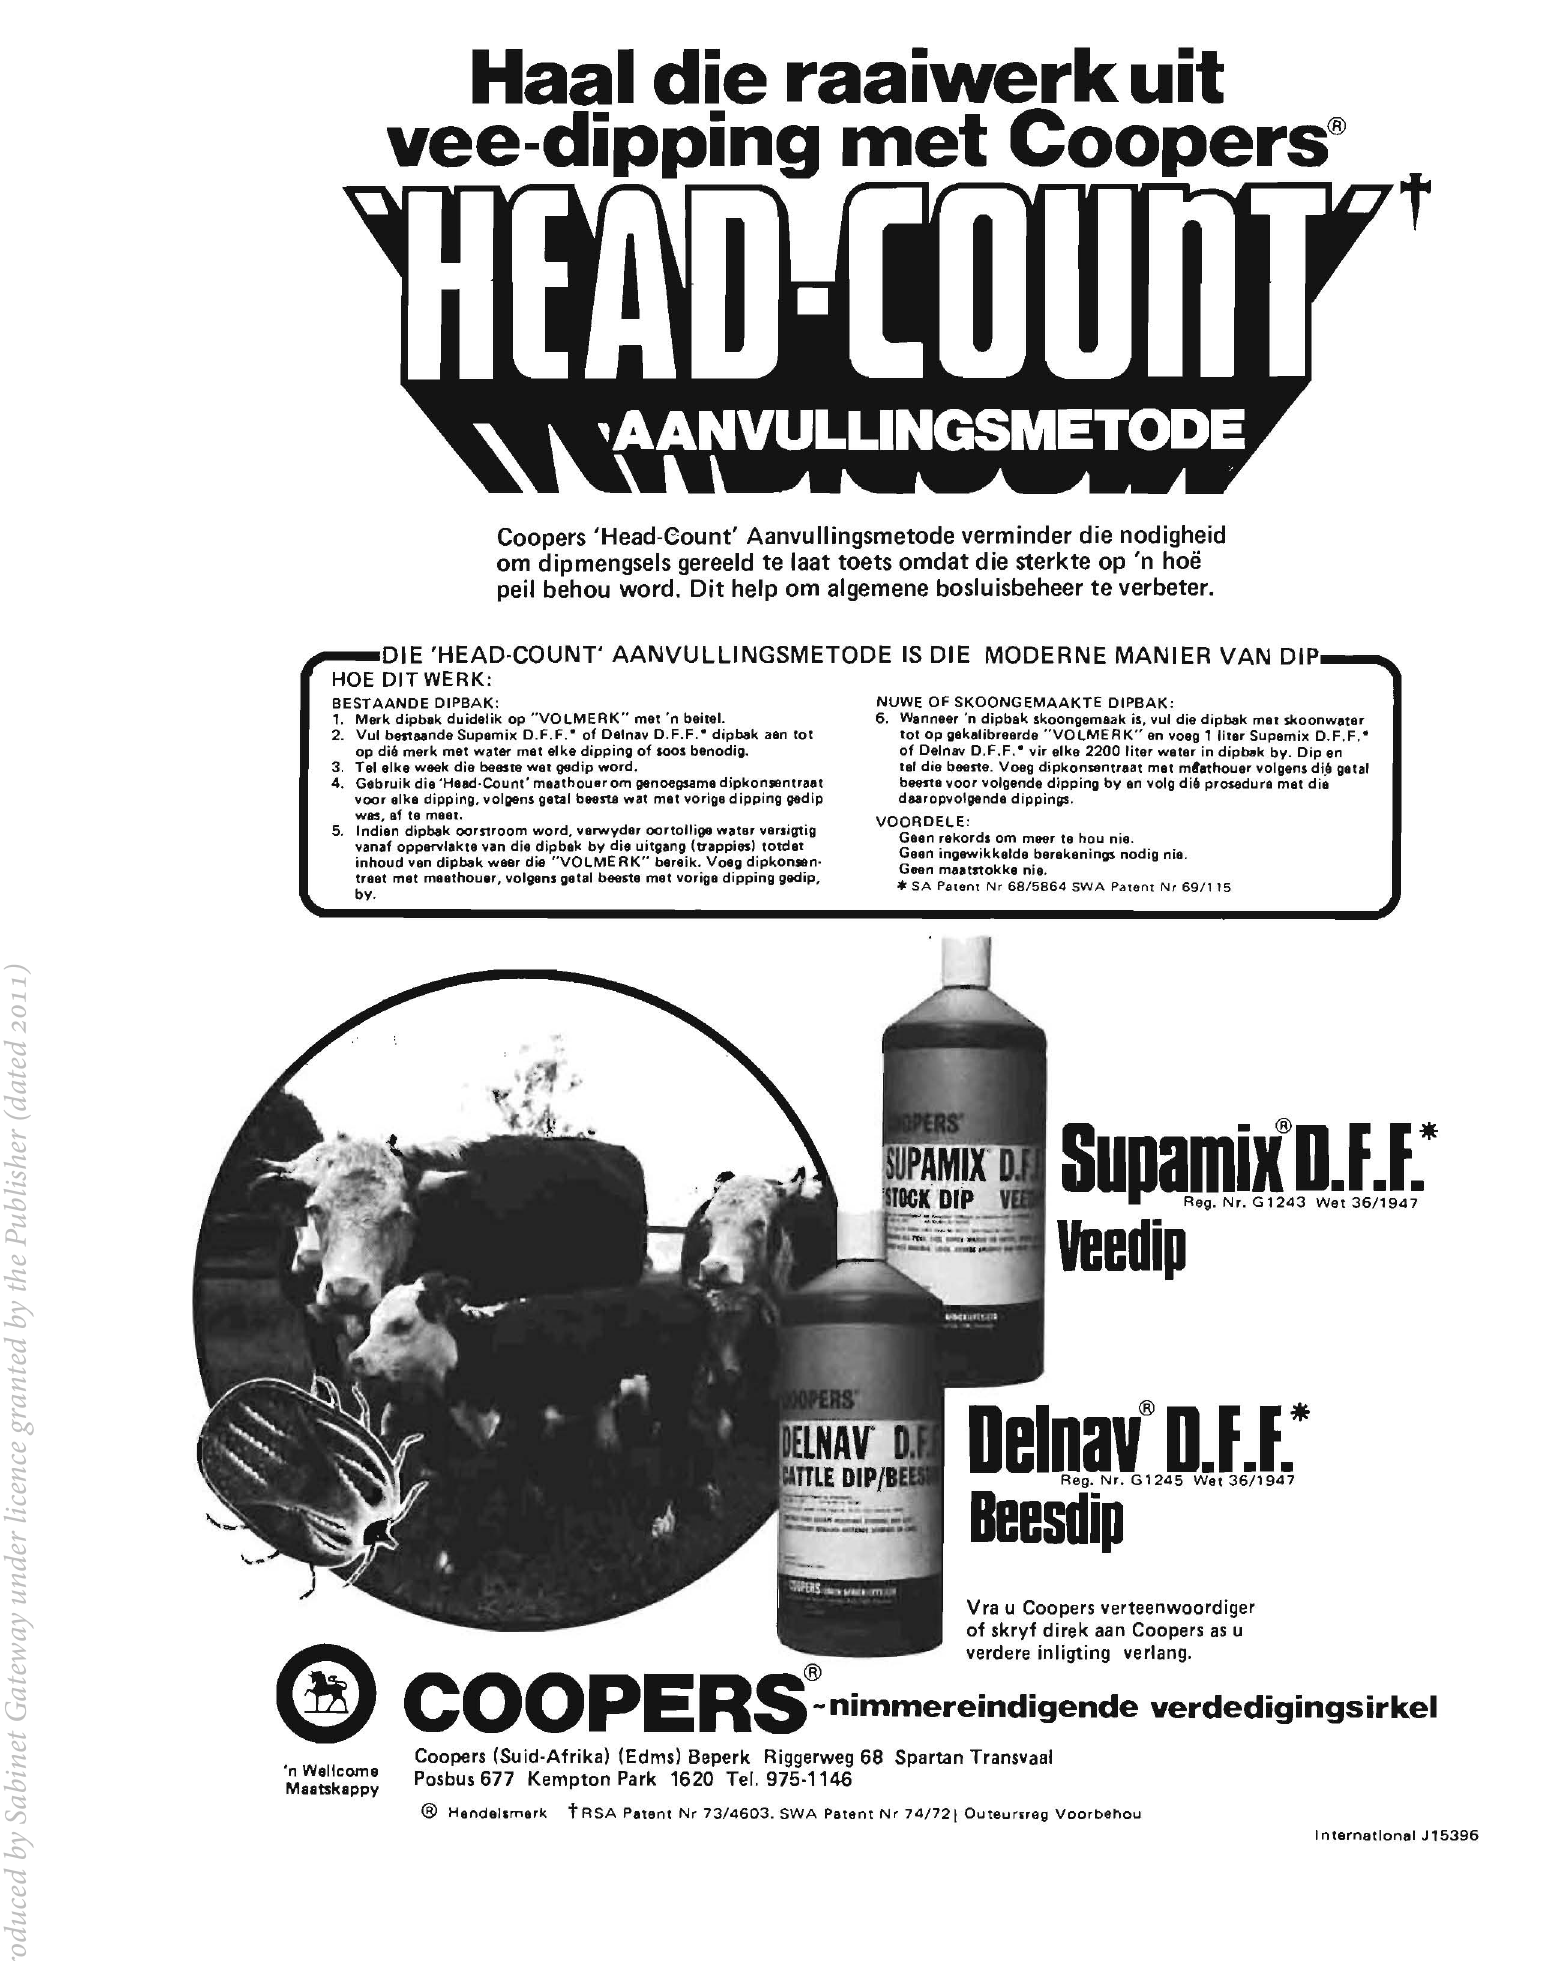
Coopers (Suid-Afrika) (Edms) Beperk Riggerweg 68 Spartan Transvaal Posbus 677 Kempton Park 1620 Tel. 975·1146 ® Hendel'merk tRSA Paten. Nr 73/4603. SWA Patent Nr 74/721 Outeu",ag Voorbehou